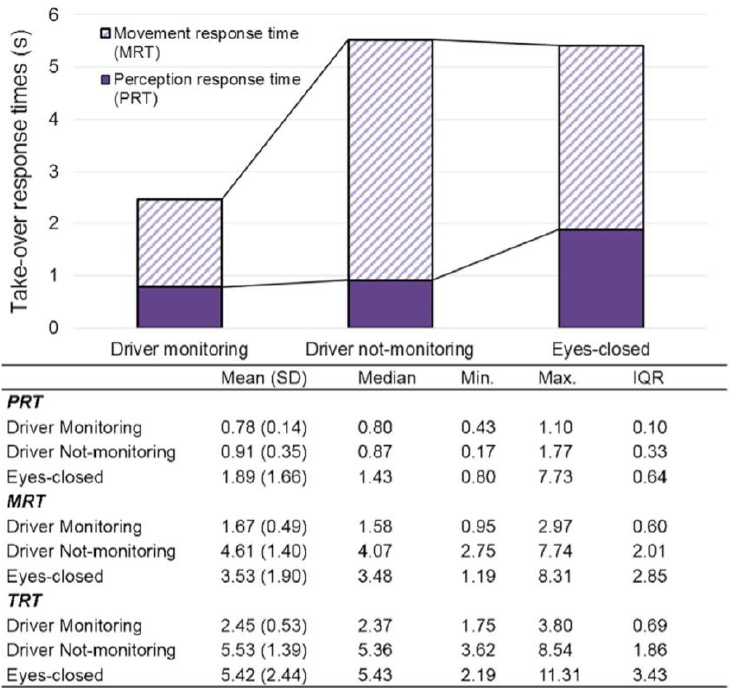
Figure 5. Difference in perception response time (PRT) and movement response time (MRT) for transition of control (from (Zhang et al.